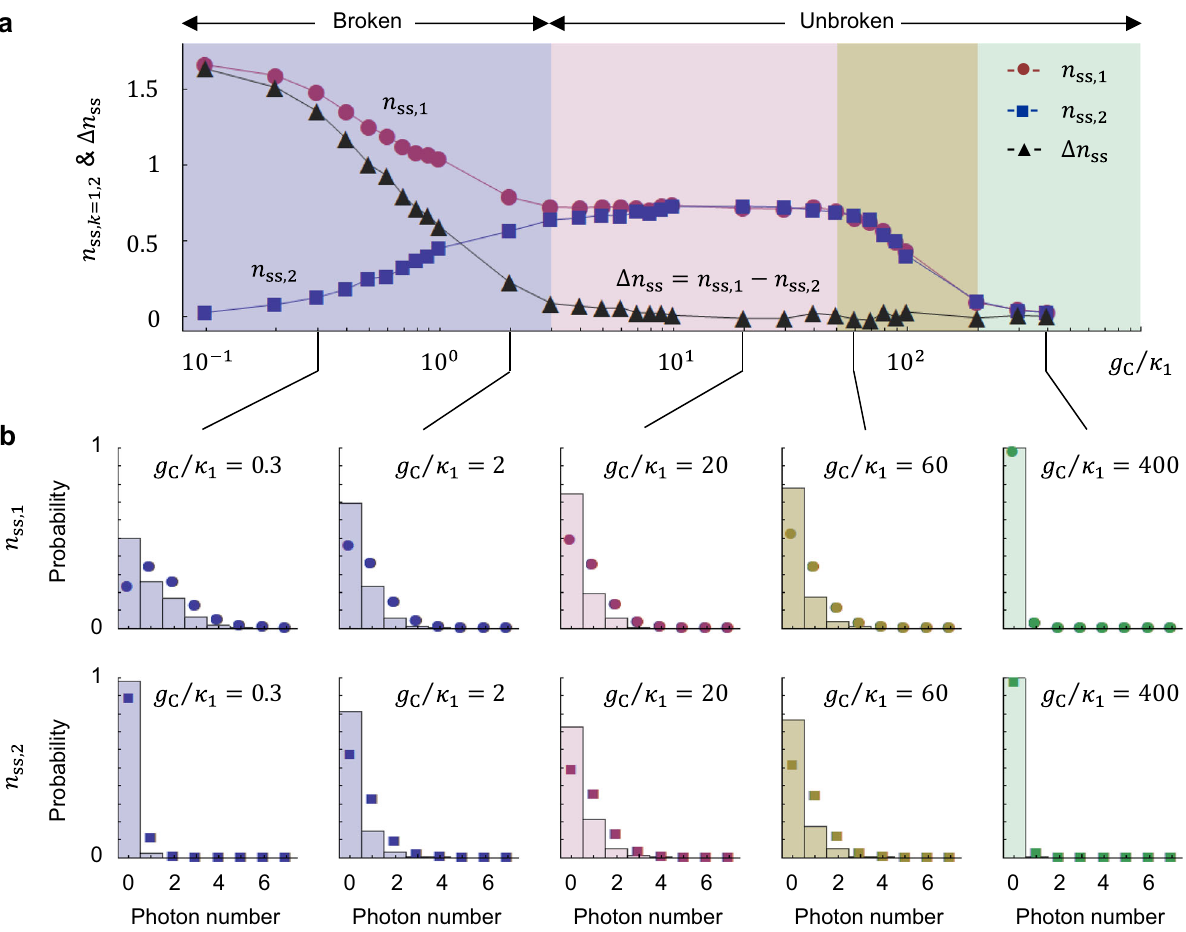
Fig. 5 Steady-state intracavity photon numbers of the microscopic-sized open system composed of a microlaser interacting with an empty optical cavity. a Dependence of n ss ; k ¼ 1 ; 2 and the photon difference Δ n ss ¼ n ss ; 1 (cid:2) n ss ; 2 on the intercavity coupling strength g C . Here, the subscript ss denotes the steady-state solutions and k ¼ 1 ; 2 represent the cavities 1 and 2, respectively. The loss rate κ 1 of cavity 1 is chosen as the frequency unit in the plot. Four regimes are presented according to the slope sign change of the n ss ; k ¼ 1 ; 2 vs. g C curves. In the fi rst regime, n ss ; k ¼ 1 ; 2 are apparently different and the coupled system is in the PT-symmetry broken phase. In the rest three regimes, Δ n ss approximates zero and the coupled system is in the PT-symmetry unbroken phase. b Normalized photon distributions of two cavity fi elds for different g C (histograms). The Poisson distributions based on the corresponding n ss ; 1 (circles) and n ss ; 2 (squares) are shown for